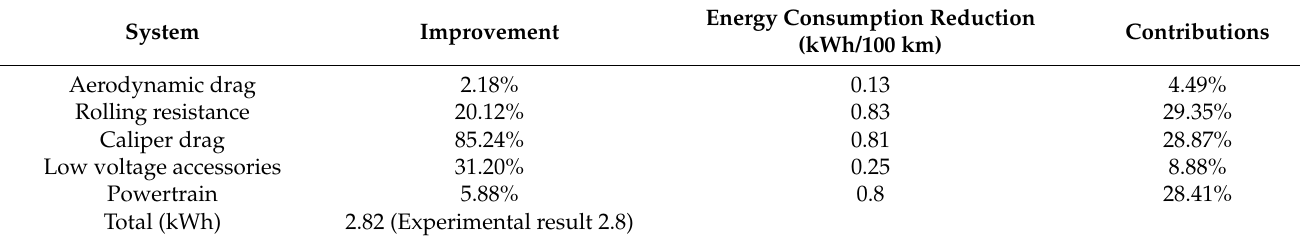
Table 1. Systematic contributions to EV modes energy consumption reduction.